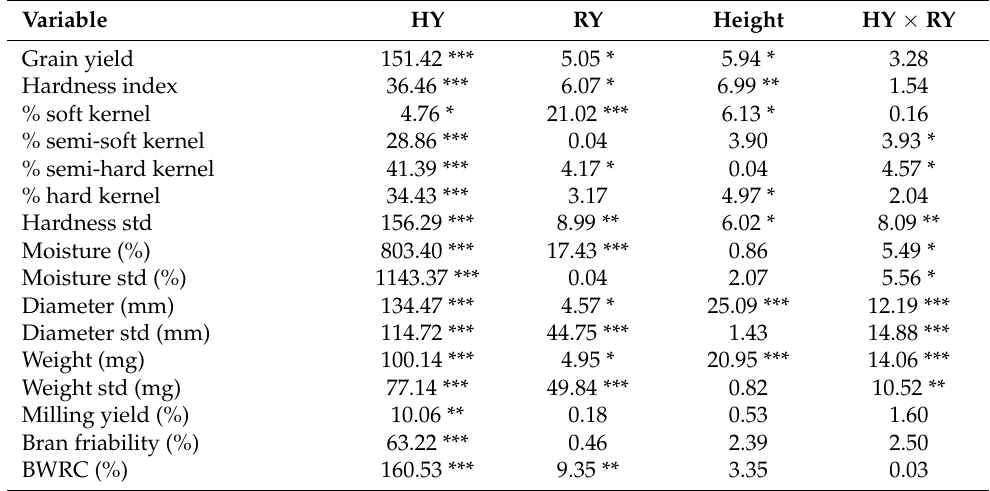
Figure 2. Kernel characteristics and grain yield with significant trends across release year. For variables with a significant release year × harvest year interaction, least squares means are plotted by harvest year. For variables where only the main effect of release year was significant, least squares means are plotted across both harvest years. Regression lines are plotted only for data with a significant trend across release year. The gray shaded area shows the 95% confidence interval of the regression line. Table 2. ANOVA (mean squares) among kernel physical characteristics and release year, harvest year, and their interaction with plant height as a co-variate.